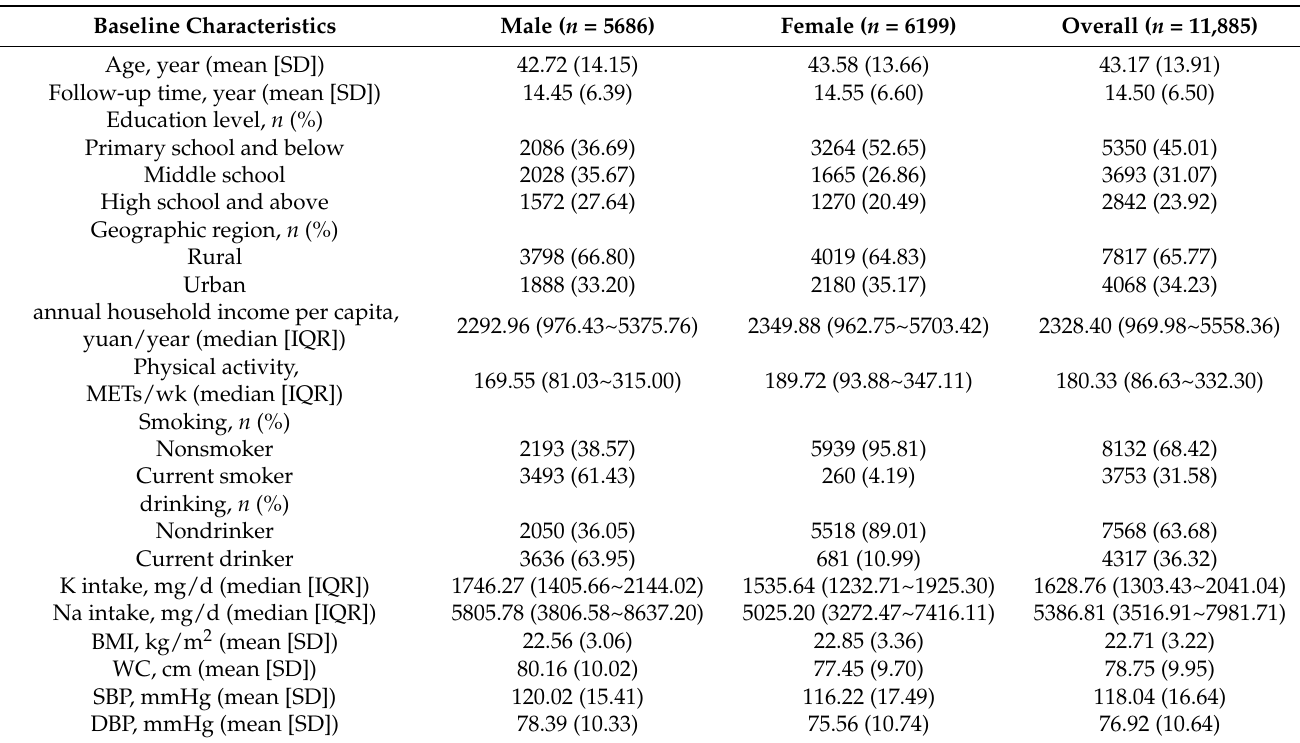
Table 1. Baseline